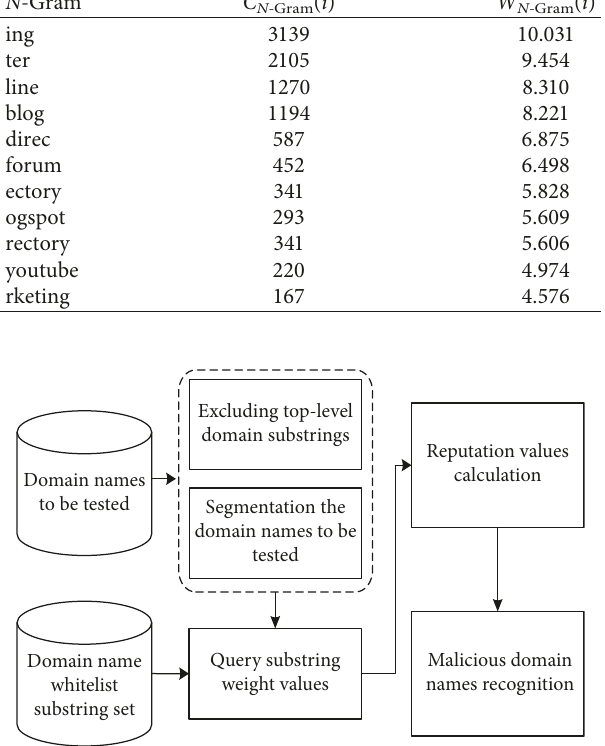
Figure 4: Flow of malicious domain names